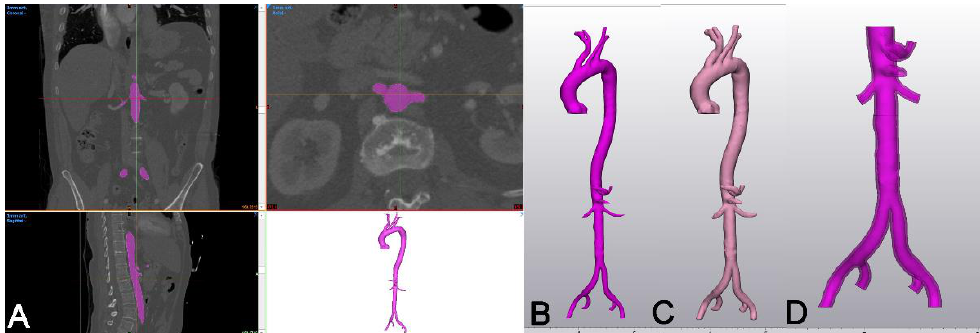
Figure 2. Generation of the original STL file (source STL). ( A ): With the Mimics Innovation Suite (MIS) software package, the blood volume (aorta and iliac bifurcation, fuchsia) was segmented from the original DICOM dataset (resolution 1 mm) and transformed into an STL file. ( B ): The STL file of the blood volume was then imported into the 3Matic module of MIS. ( C ): Using the “hollow” tool, a wall thickness of 2 mm was applied externally to the aorta. ( D ): Finally, the ostia were opened using the “trim” tool and the part of interest (abdominal aorta) of the model was exported as an STL file.